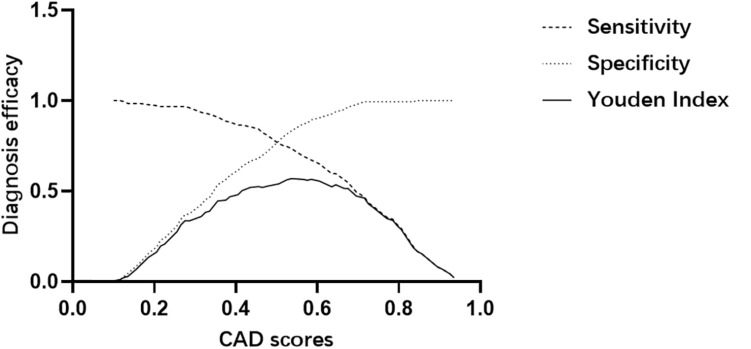
Determination of the positive threshold for the CAD system score through the Youden index.